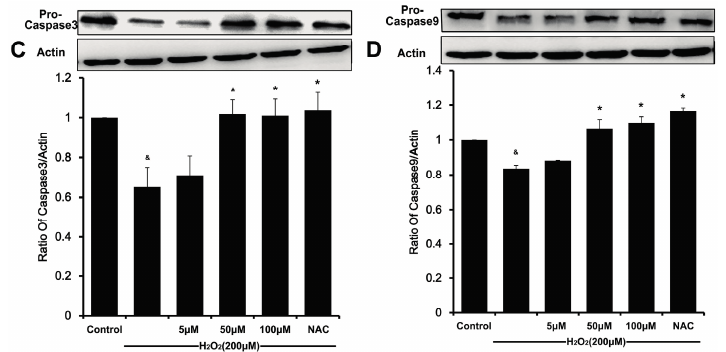
Figure 8. DSC modulated apoptosis-related proteins expression in H 2 O 2 -stimulated HUVEC. HUVEC were incubated with indicated concentrations of DSC or NAC for 4 h, then stimulated with H 2 O 2 (200 μ M) for 12 h; the Bcl-2 ( A ); Bax ( B ); caspase-3 ( C ); and caspase-9 ( D ) were measured by Western blot, respectively. Western blot and densitometric analysis for Bcl-2 ( A ); Bax ( B ); caspase-3 ( C ); and caspase-9 ( D ). β -actin was used as loading control. Protein expression in control cells was set to 1. Data shown are means ± SEM, & p < 0.05 compared with unstimulated cells, * p <